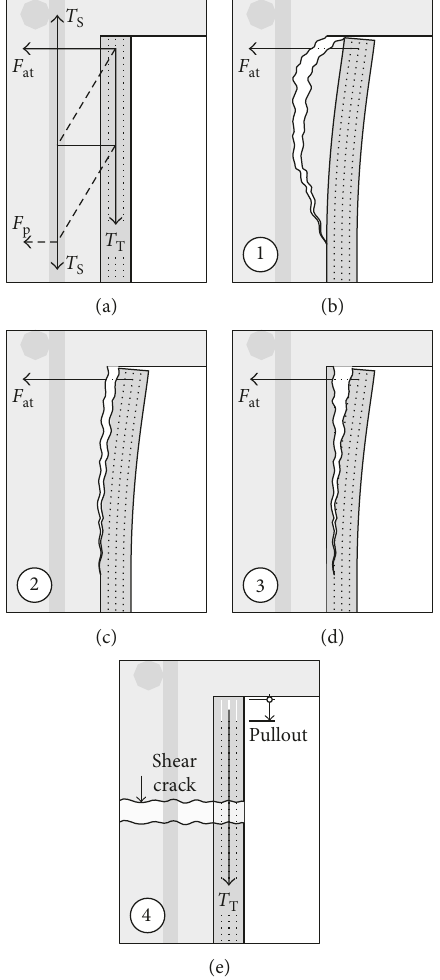
Figure 1: Bond failure modes of a TRC strengthening applied to an RC surface (e.g., shear strengthening of a T-beam) based on the study of Ortlepp et al. [50]. (a) Strut-and-tie model of TRC anchoring. (b) Failure mode: old concrete. (c) Failure mode: joint old-new. (d) Failure mode: delamination. (e) Failure mode: textile